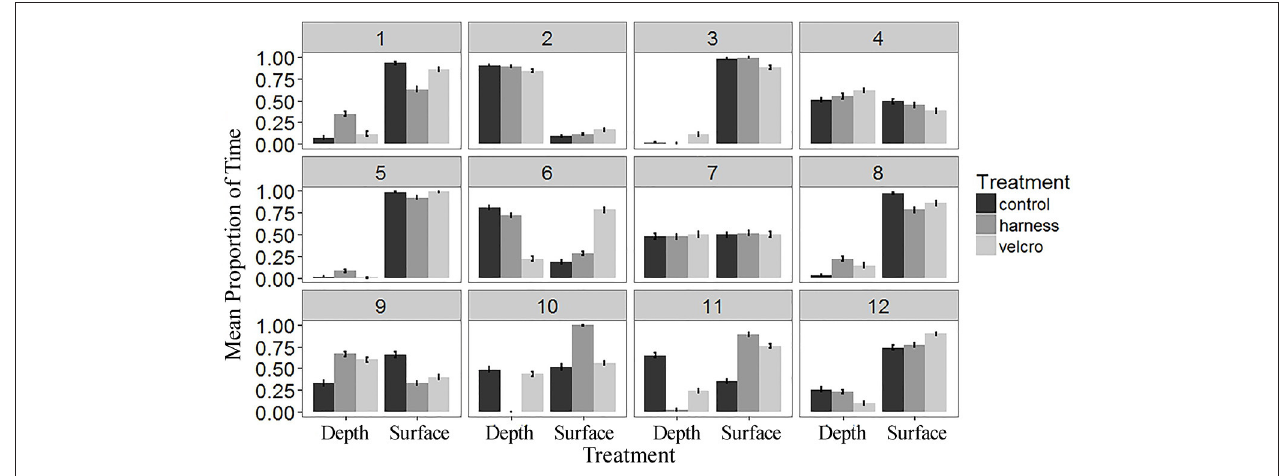
FIGURE 5 | The mean proportion of time spent below 15cm (“Depth”) and at the surface (“Surface”) by subject and treatment over the study period. Water column depth was measured every second over the 25min study period. Each subject is indicated by the number in the grey box. Error bars represent standard errors.